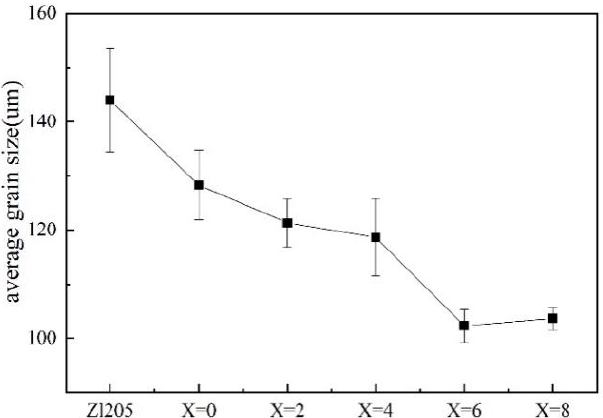
Figure 2. ZL205 alloy grain size after the addition of the 0.3 wt% Al-TiO 2 -C- X Er 2 O 3